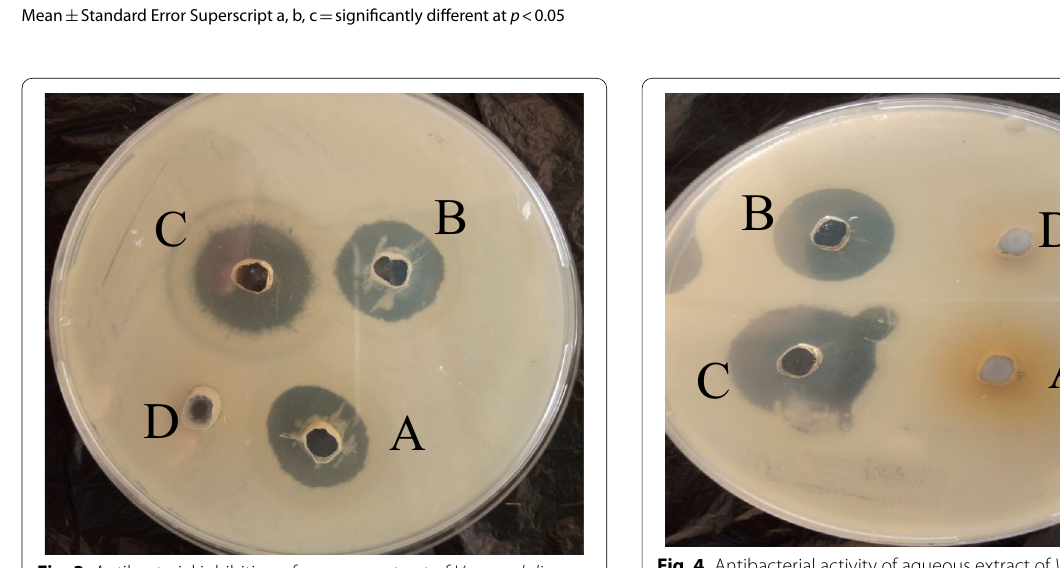
Fig. 3 Antibacterial inhibition of aqueous extract of V. amygdalina leaf against Staphylococcus aureus . Keys: A C 100 mg/ml, D negative control. Negative control = =